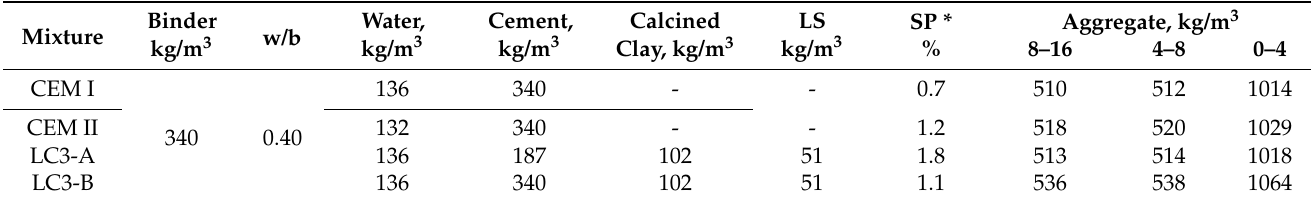
Table 4. Mixture design of all mixtures used in this